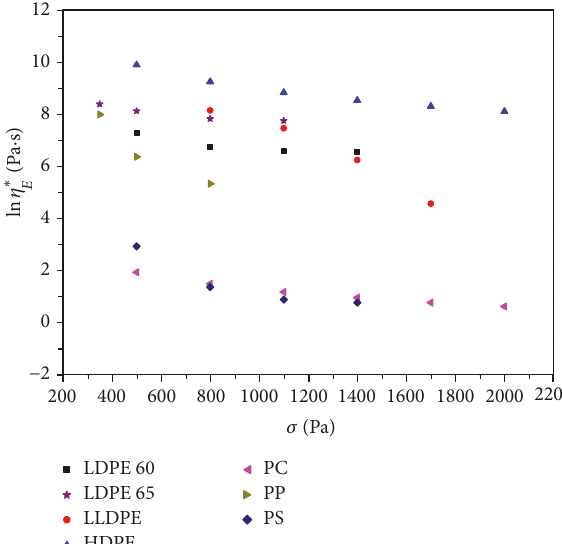
Figure 11: The elongational stress dependency of computed ln 𝜂 ∗ 𝐸 calculated by (7) and